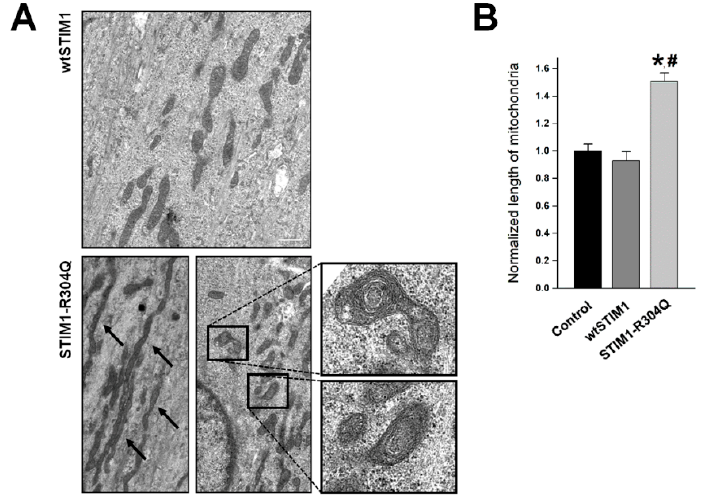
Figure 4. Shapes of mitochondria: ( A ) mitochondria of wtSTIM1- or STIM1-R304Q-expressing myotubes were observed using TEM. Mitochondria with concentrically laminated bodies (enlarged images) or long mitochondria (indicated by arrows) were found in STIM1-R304Q-expressing myotubes. The bar represents 2 μ m; ( B ) mitochondrial length was measured. The mean values of each normalized to the mean value of the control are summarized as histograms (Table 1). * Significant difference compared with the control ( p < 0.05). # Significant difference compared with wtSTIM1 ( p < 0.05).